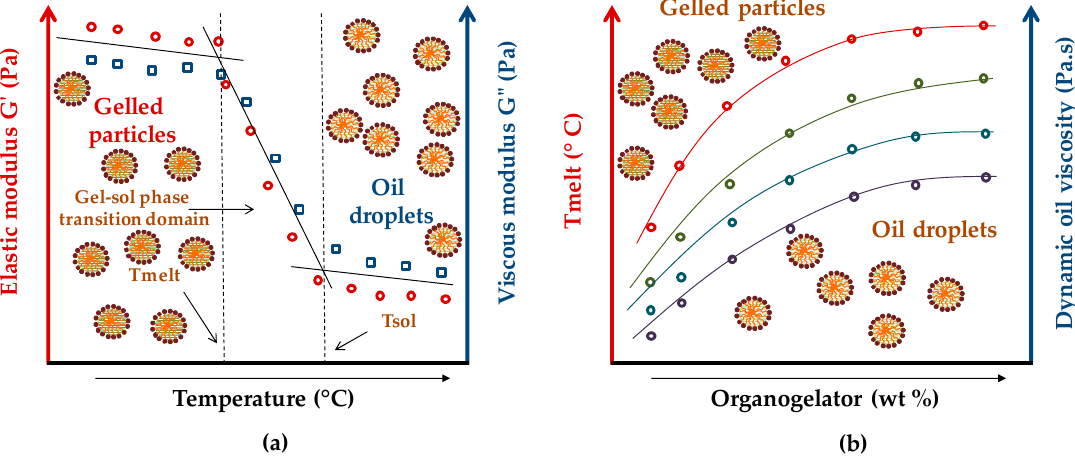
Figure 8. Gel–sol phase transition parameter evolution of GLN dispersion: ( a ) Tmelt, Tsol, and gel–sol PTD value determination according to the temperature increase; ( b ) Tmelt value evolution according the organogelator wt % and the dynamic oil viscosity increase.